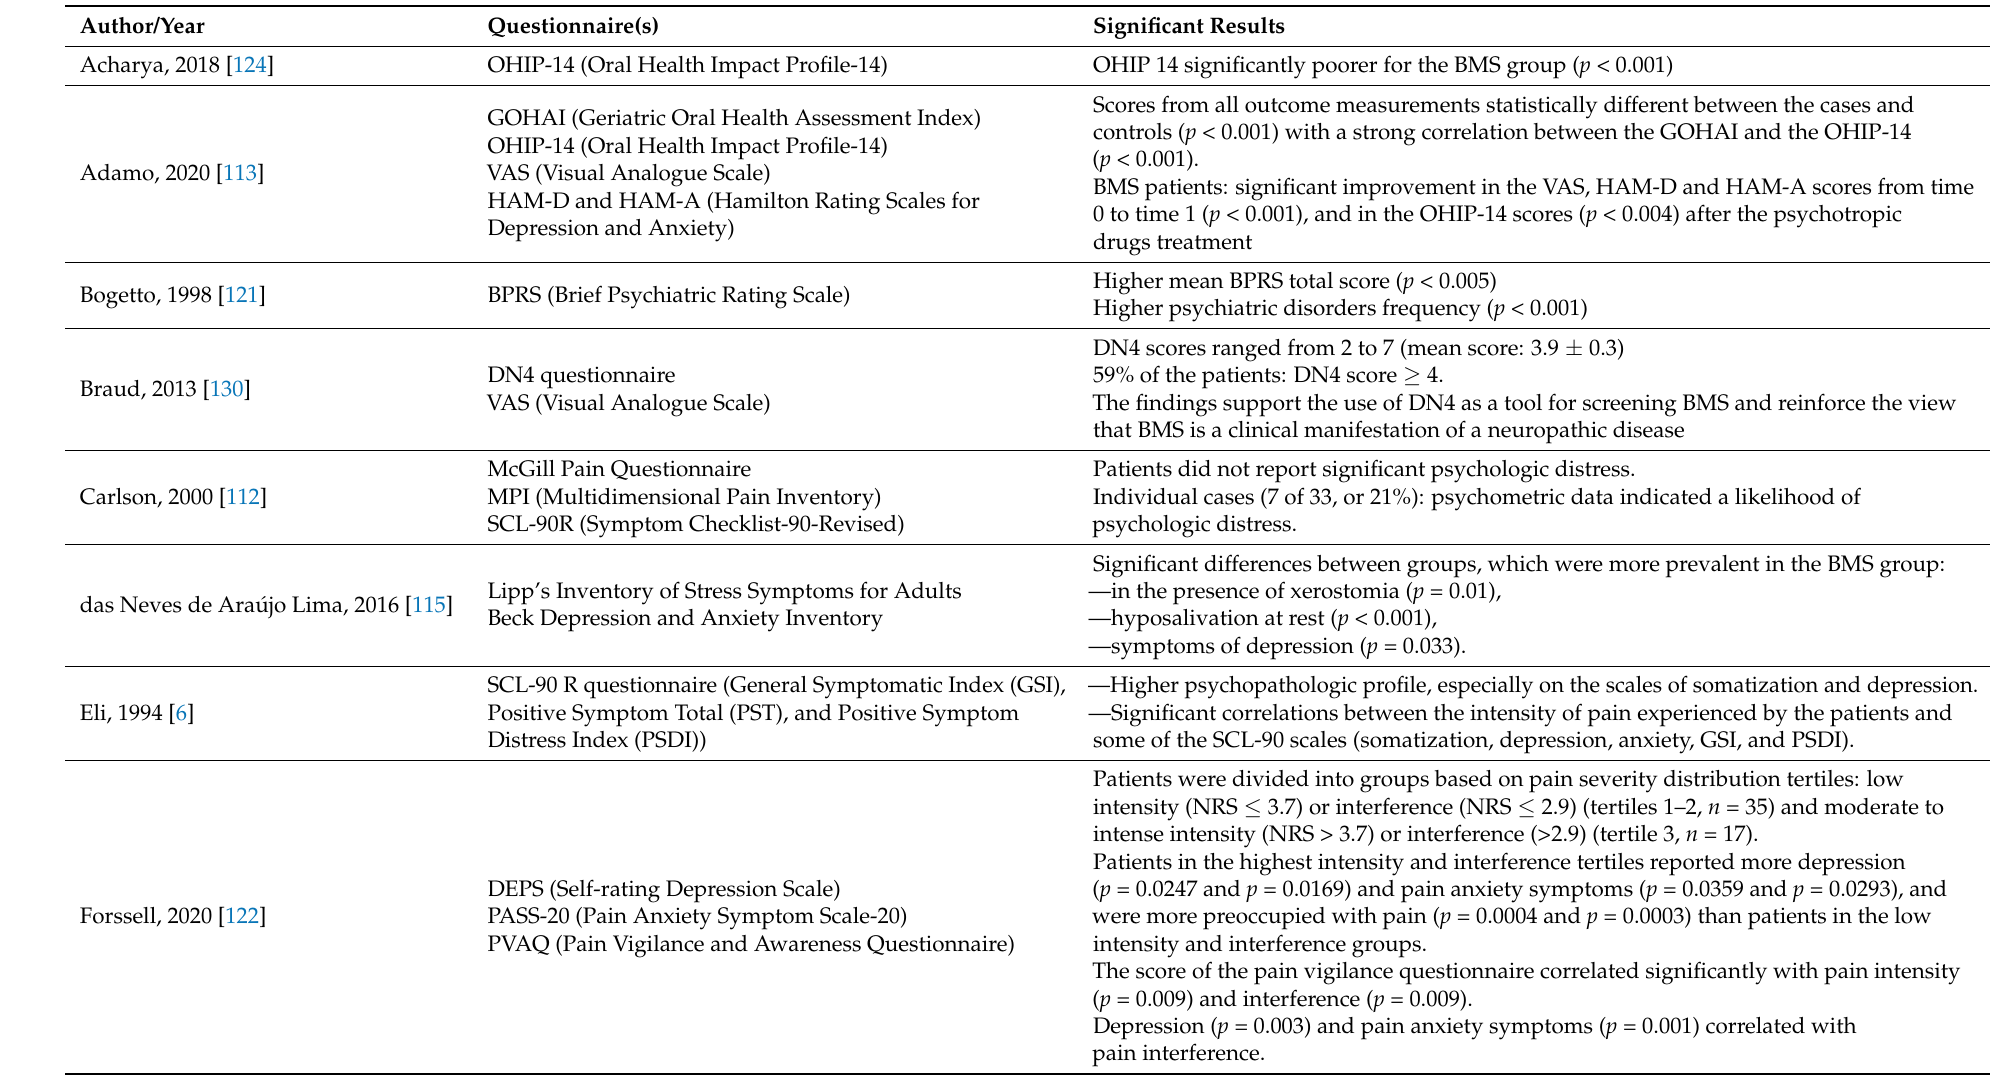
Table 2. Overview of the included questionnaire-based studies (in alphabetic order by